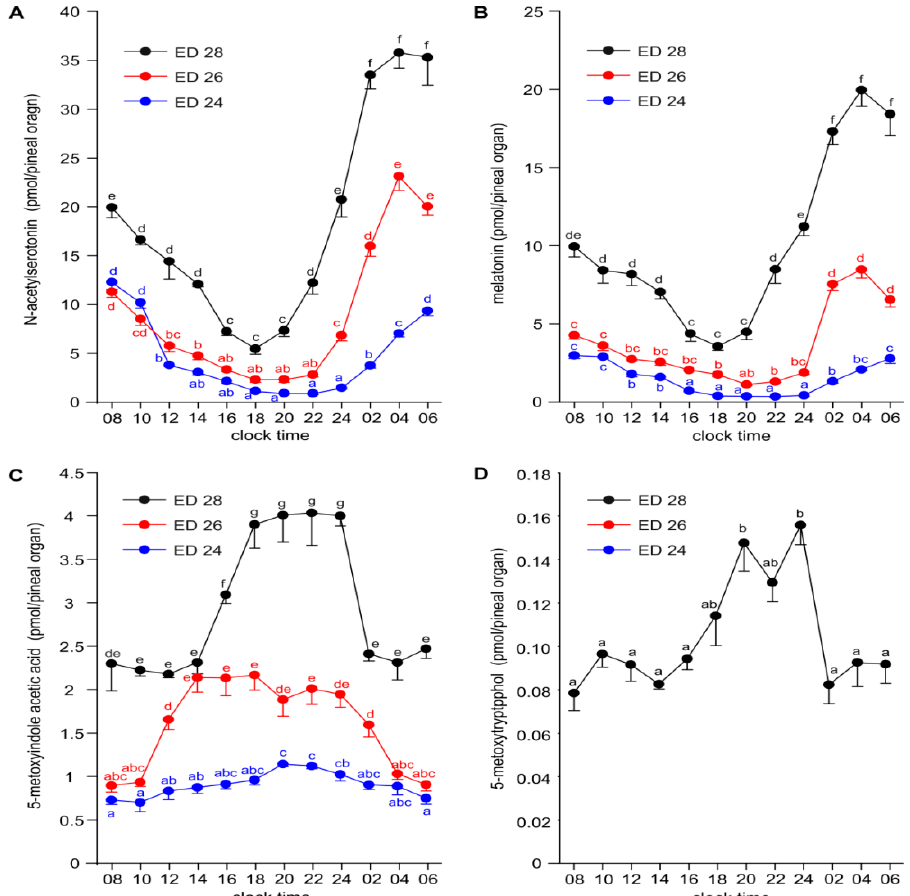
Figure 5. Diurnal changes in the content of N-acetylserotonin ( A ), melatonin ( B ), 5-methoxyindole acetic acid ( C ) and methoxytryptophol ( D ) in the pineal organs of geese embryos on ED 24, ED26 and ED 28 (means and SEM, n = 5). Values labeled with different letters are significantly different.